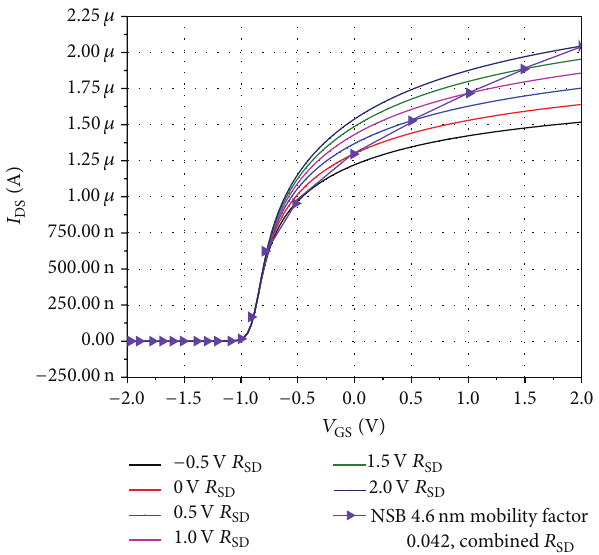
Figure 7: The variation of simulated 𝐼 DS - 𝑉 GS for each extracted resistance values in the range of − 0.5 V to 2V with 0.5 V steps. 𝑉 DS is fixed to